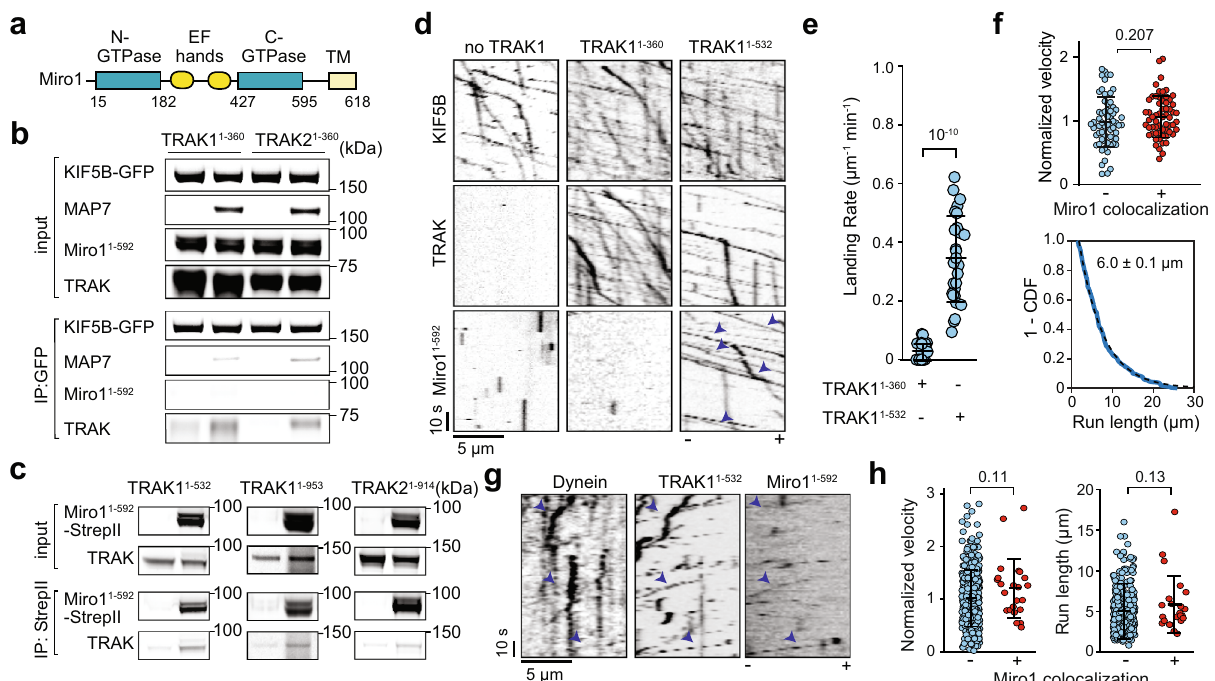
Fig. 5 | Miro1 is transported by KT and DDT complexes. a Miro1 binds to GTP at its GTPase domains and Ca 2+ ions at its EF-hands and localizes to the outer mito- chondrial membrane through its transmembrane (TM) domain. b In vitro immu- noprecipitation of puri fi ed KIF5B-GFP-SNAPf, TRAK1 1 – 360 or TRAK2 1 – 360 , Miro1 1 – 592 with or withoutMAP7. c , In vitroimmunoprecipitationofpuri fi edMiro1 1 – 592 -StrepII andeitherTRAK1 1 – 532 ,full-lengthTRAK1 1 – 953 ,orfull-lengthTRAK2 1 – 914 inthepresence of GTP γ S. KIF5B-GFP-SNAPf was present in all conditions. d Kymographs of Alexa488-KIF5B and LD655-Miro1 1 – 592 in the absence of a TRAK adaptor or the presenceofLD555-TRAK1 1 – 360 orTRAK1 1 – 532 .Assayswereconductedat10nMMAP7. Arrowheads show colocalization of Miro1 to TRAK. e The landing rate of KTM co- localizers in the presence of different TRAK constructs ( n = 27 MTs for each